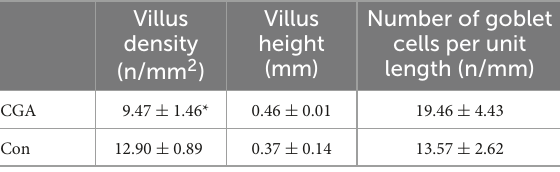
*Indicates a significant difference compared to the control group ( P < 0.05). The acronym for the CGA-added group is CGA and the acronym for the